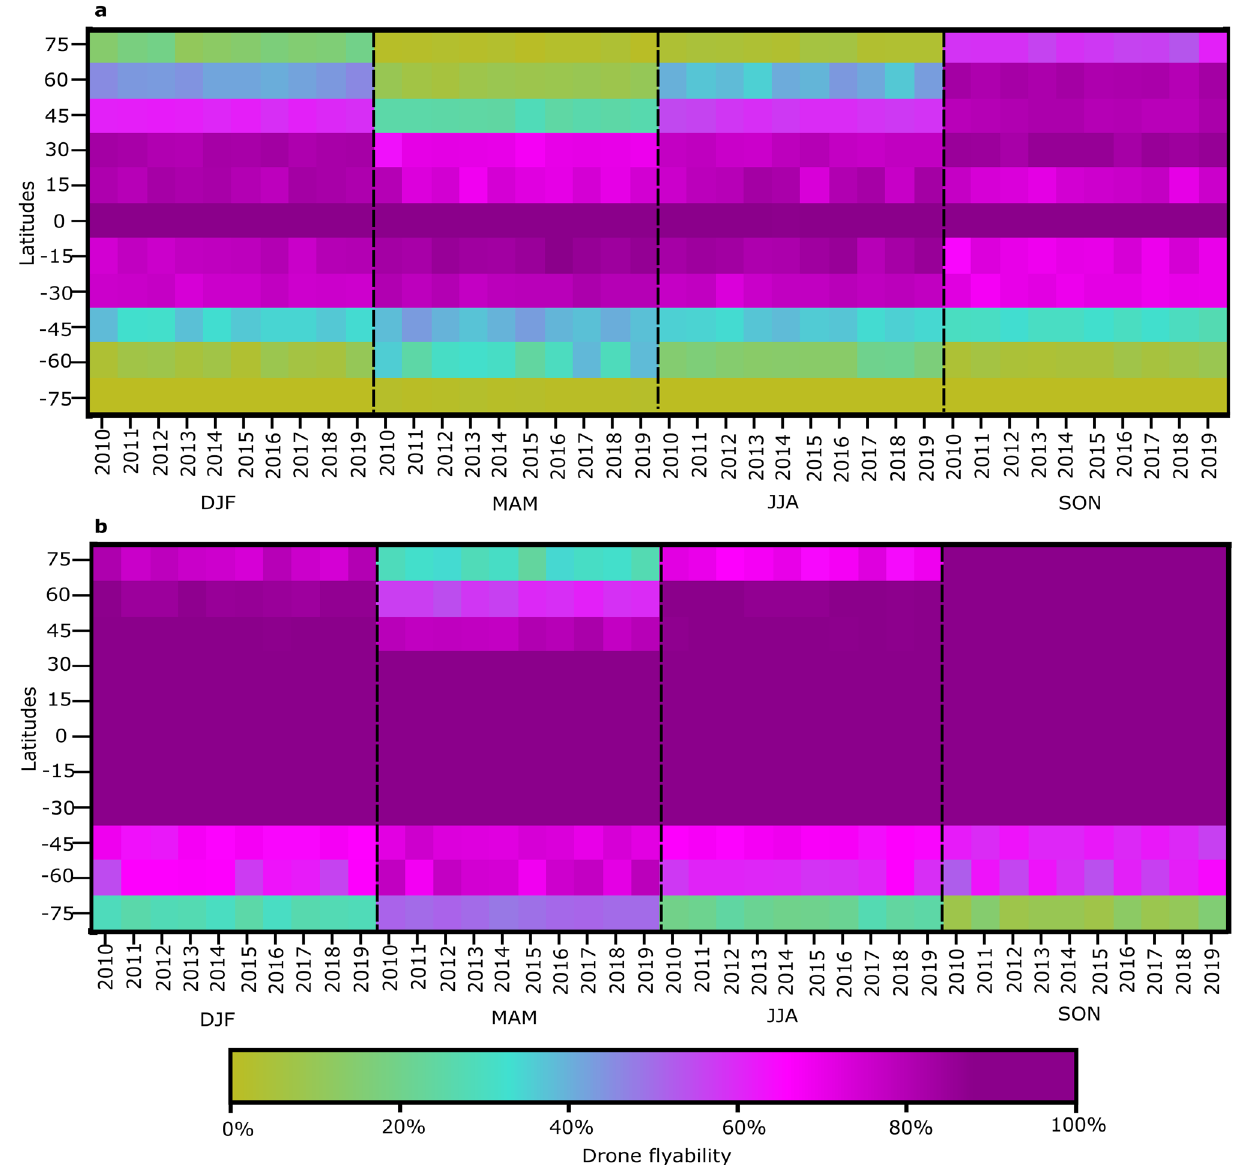
Figure 4. Flyability by year and season for CD ( a ) and WRD ( b ) at select latitudes (day-and-night). DJF December–January–February, MAM March–April–May, JJA June–July–August, SON September–October–